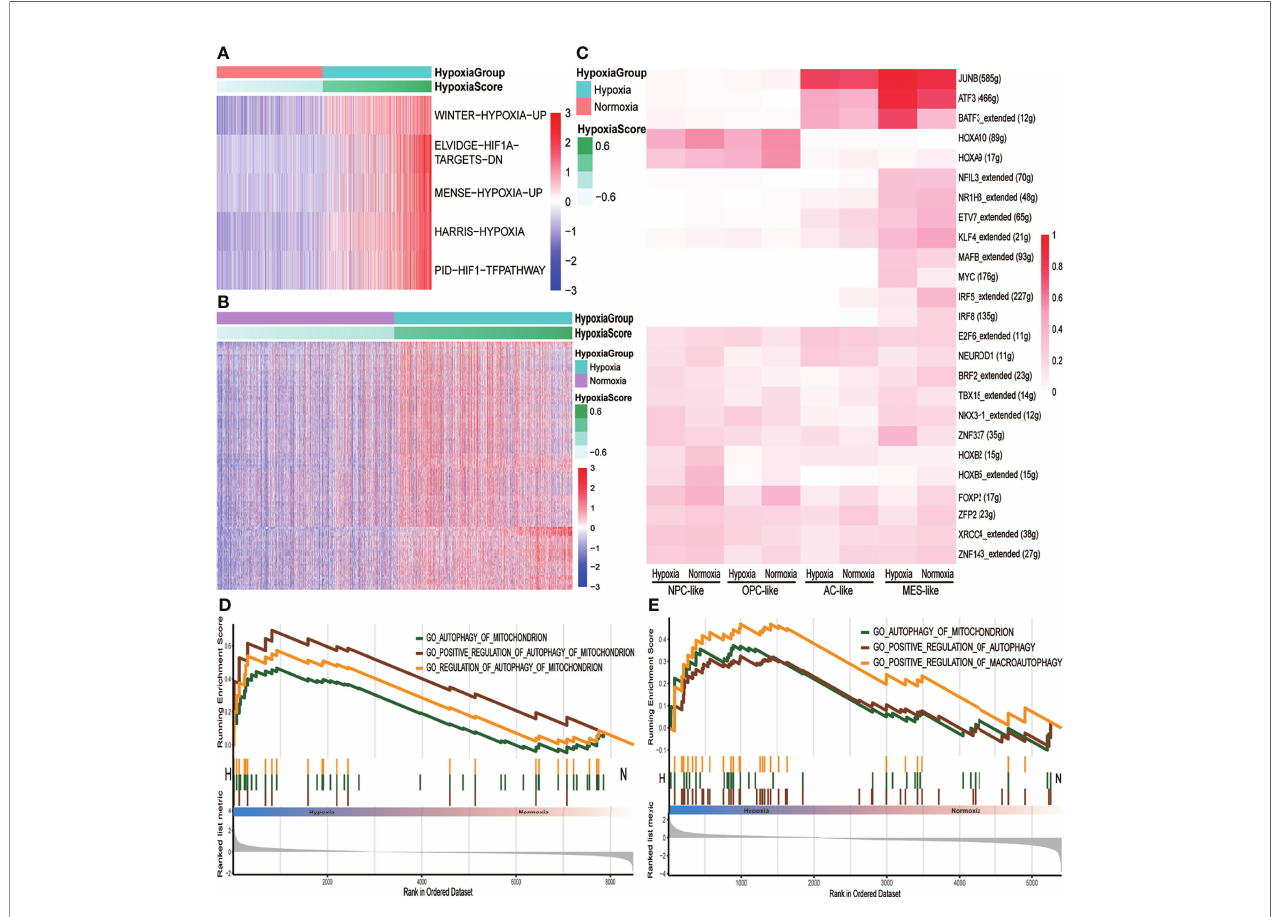
FIGURE 3 | The different pathway activities between hypoxia and normoxia groups. (A) Heatmap of KEGG metabolism pathway activity between hypoxia and normoxia groups within tumor cells. (B) Heatmap of msigdb C7 immune signatures between hypoxia and normoxia groups within tumor cells. (C) Heatmap of binarized regulon network activity of different tumor cell subtype under hypoxia or normoxia. (D) GSEA analysis plot of autophagy-related pathways in tumor cells under hypoxia condition with p < 0.05. (E) GSEA analysis plot of autophagy-related pathways in MES-like tumor cells under hypoxia condition with p <